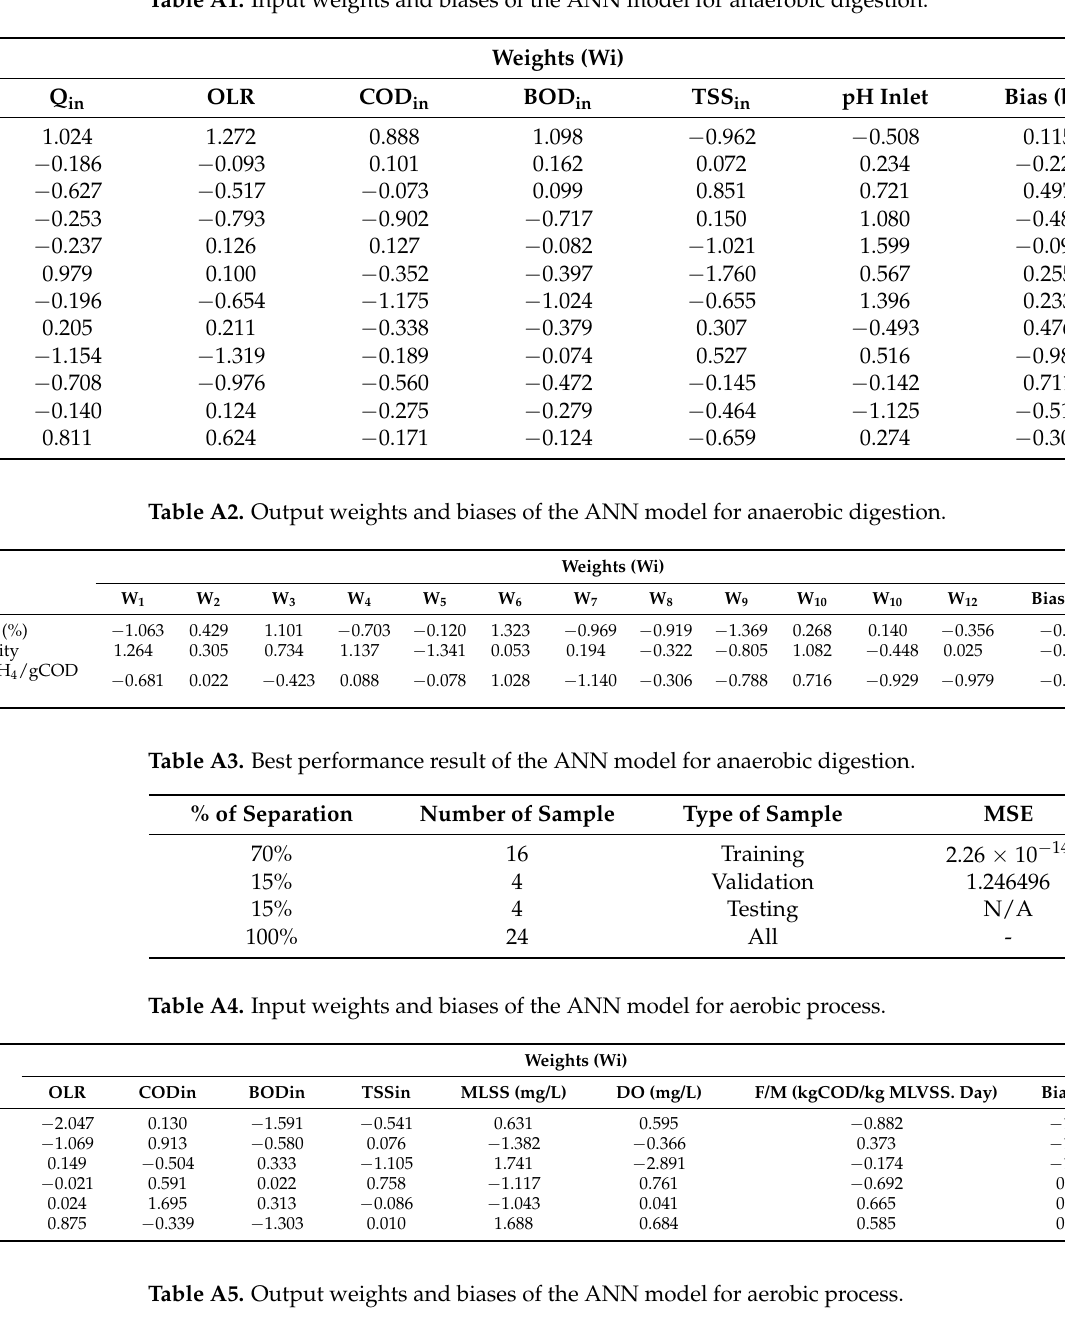
Table A1. Input weights and biases of the ANN model for anaerobic digestion.